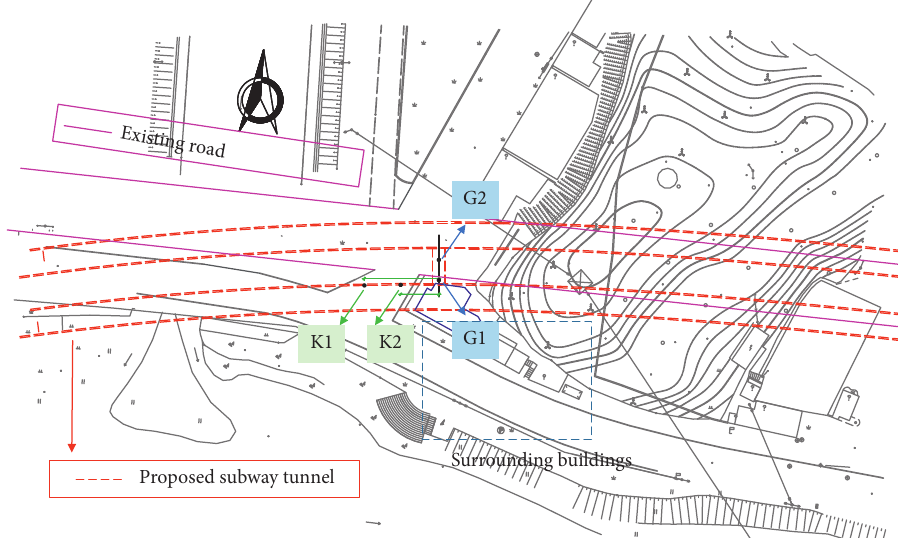
Figure 13: Arrangement of vibration monitoring points.